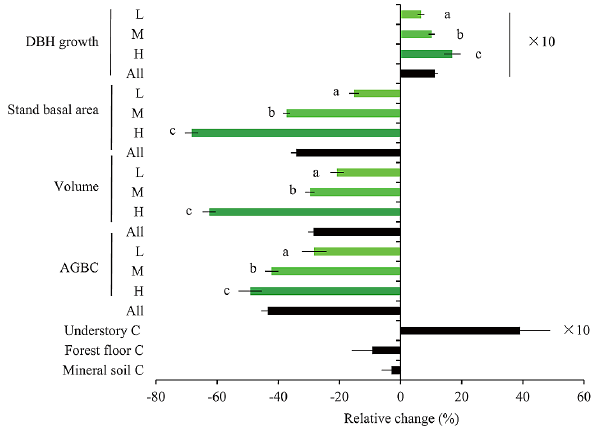
Fig. 1. Overall directions and magnitudes of the relative changes (%) in the growth of diameter at breast height (DBH growth), stand basal area, volume, aboveground biomass C (AGBC), understory C storage, forest floor C, and mineral soil C after partial cutting, compared to the uncut control. The error bars are the standard er- ror (SE). The results of one-way ANOVA ( P < 0 . 05) among three cutting intensity (CI) groups (light (L): CI < 34%; moderate (M): 34% ≤ CI < 67%; and heavy (H): CI ≥ 67%) are shown beside the error bars, with a different letter meaning a difference significant at P < 0 . 05. The values on the x-axis for DBH growth and understory C are 10 times those of other variables.